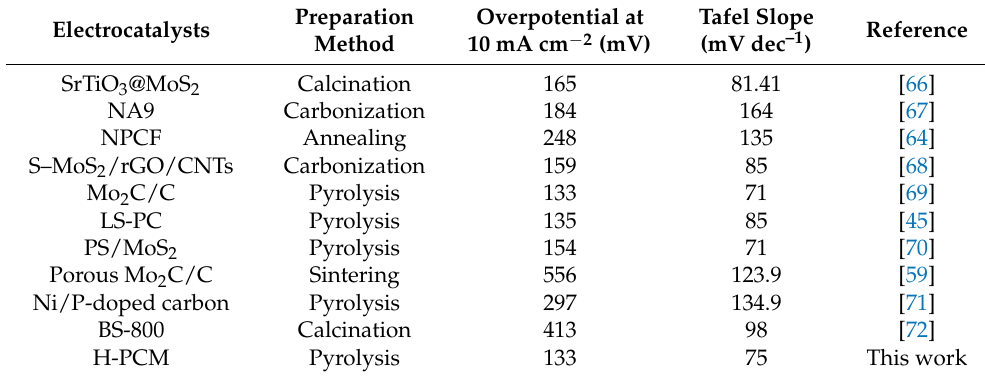
Table 1. The HER performances of H-PCM were compared with the reported